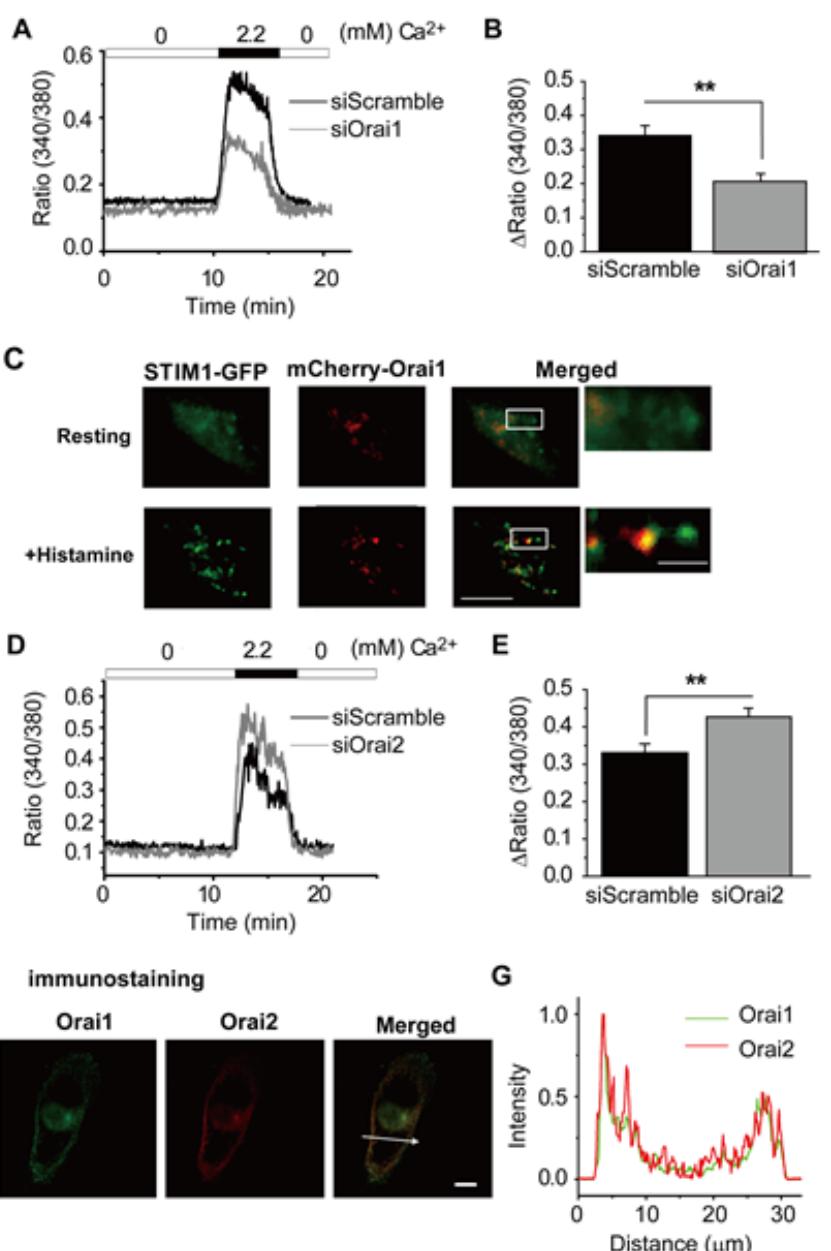
Figure 5. ( A ) shows [Ca 2 + ] i changes following ER store depletion due to addition of 2 µ M thapsigargin to OUMS-27 cells that had been transfected with either siOrai1 or siScramble. ( B ) summarizes the data based on the Ca 2 + signal (** p < 0.01). ( C ) Molecular dynamics based on Orai1 and STIM1 interactions were visualized under physiological conditions. Note that application of 10 µ M histamine-induced punctate STIM1–Orai1 complex formation. Scale bars denote 5 µ m (left) and 1 µ m (right), respectively. ( D ) Compares SOCE in cells transfected with siOrai2 or siScramble. The corresponding [Ca 2 + ] i signals compared in ( E ) demonstrates statistical significance (** p < 0.01). ( F ) Shows double immunostaining images of Orai1 (green) and Orai2 (red) in OUMS-27 cells. The scale bar denotes 10 µ m. ( G ) shows the relative intensity profile corresponding to the location of the arrow in Panel F. Note also that (yellow region in Panel F) Orai1 and Orai2 showed a similar distribution pattern (see [18]). Reprinted from Cell Calcium , 57, Inayama M et al., Orai1–Orai2 complex is involved in store-operated calcium entry in chondrocyte cell lines, 337–347, Copyright (2015), with permission from Elsevier (see [18]).